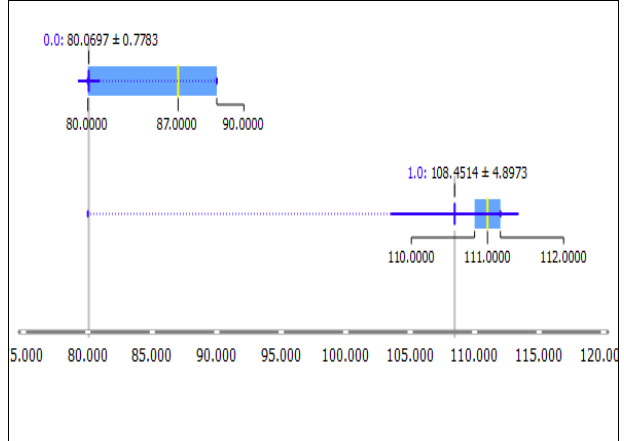
Figure 13. Data distribution of diastolic blood pressure (DBP in a box-plot, showing the range data; the mean value after clustering the data using the K -means clustering technique. Here, 0.0 represents the cluster for the non-hypertension class and 1.0 represents the hypertension class. It can be seen that the two sets of data are non-overlapping in nature.